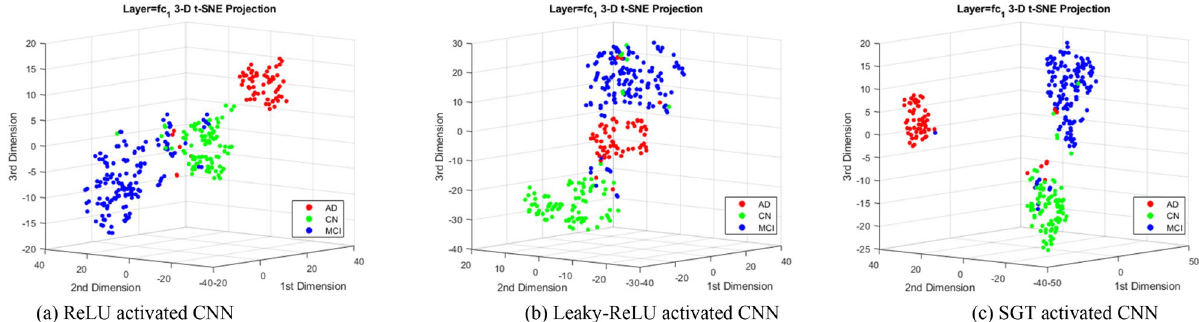
Figure 12. 3D projection viewed at the same angle for the test set features reduced from 1728 dimension to 3 using the t-SNE algorithm. Here each color dot represents an MRI scan, hence a total of 296 dots for 296 test MRI. The non-linear feature distribution shows the requirement of complex boundaries for classifications. Here the figure from left to right is obtained as the result of t-SNE distribution using ReLU, Leaky-ReLU, and SGT activation separately in the same baseline 3D CNN model. Please see Fig. 12_app in the "Appendix" section for the 3D t-SNE projection of all individual layers in the gamm4_adam